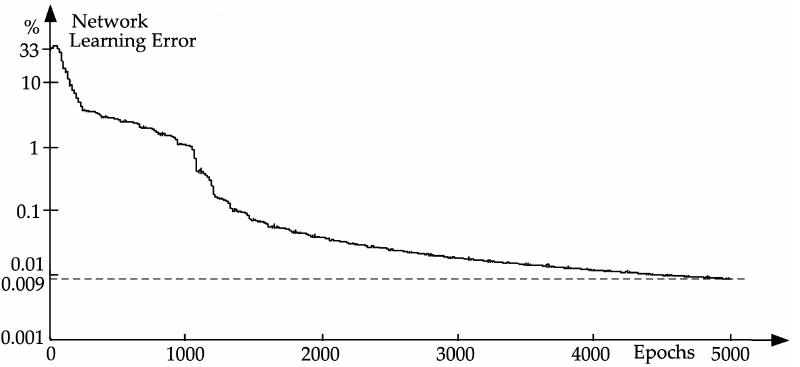
Figure 8. The mean square error of the learning process of a neural network assessing the risk of ship collision.